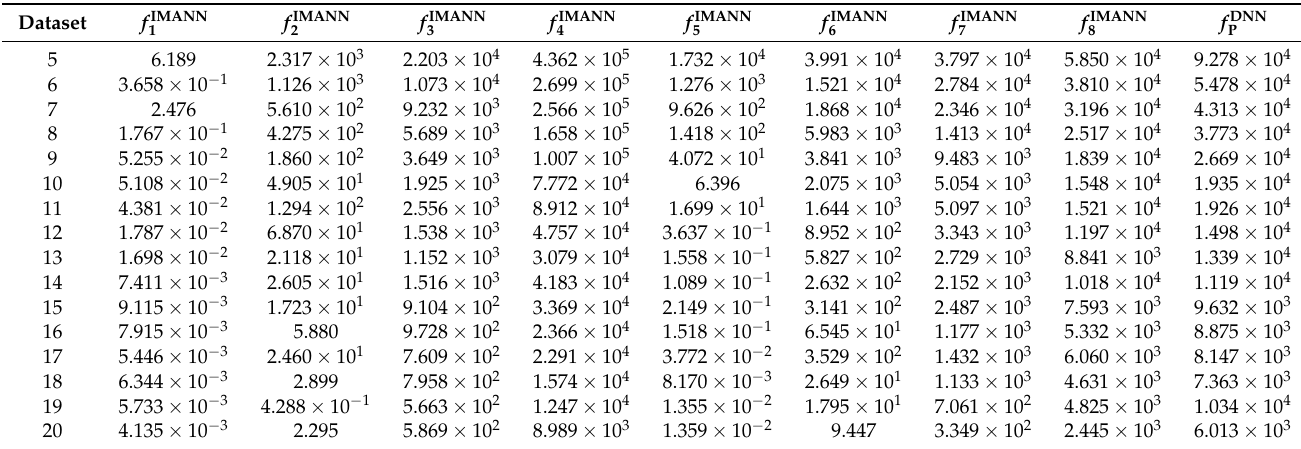
Table 1. Mean integral squared error value R m .